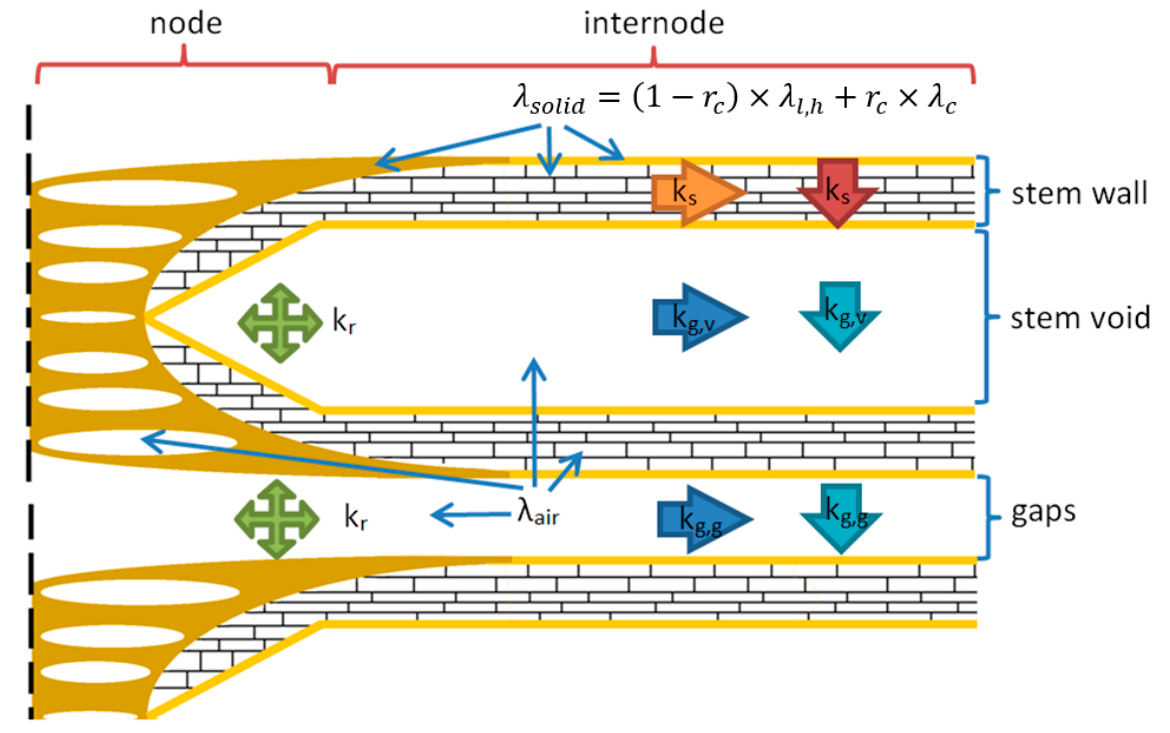
Figure 7. Components of heat transfer in the longitudinal section of straw-based fibrous media.